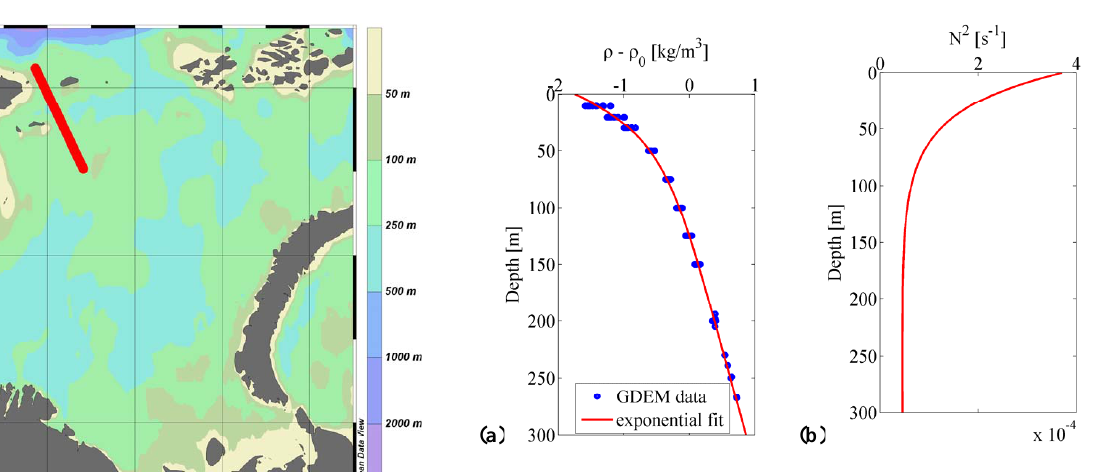
Figure 3. The typical vertical density profile (a) in the studied area and the Brunt–Väisälä frequency (b) taken from the Database GDEM for July.